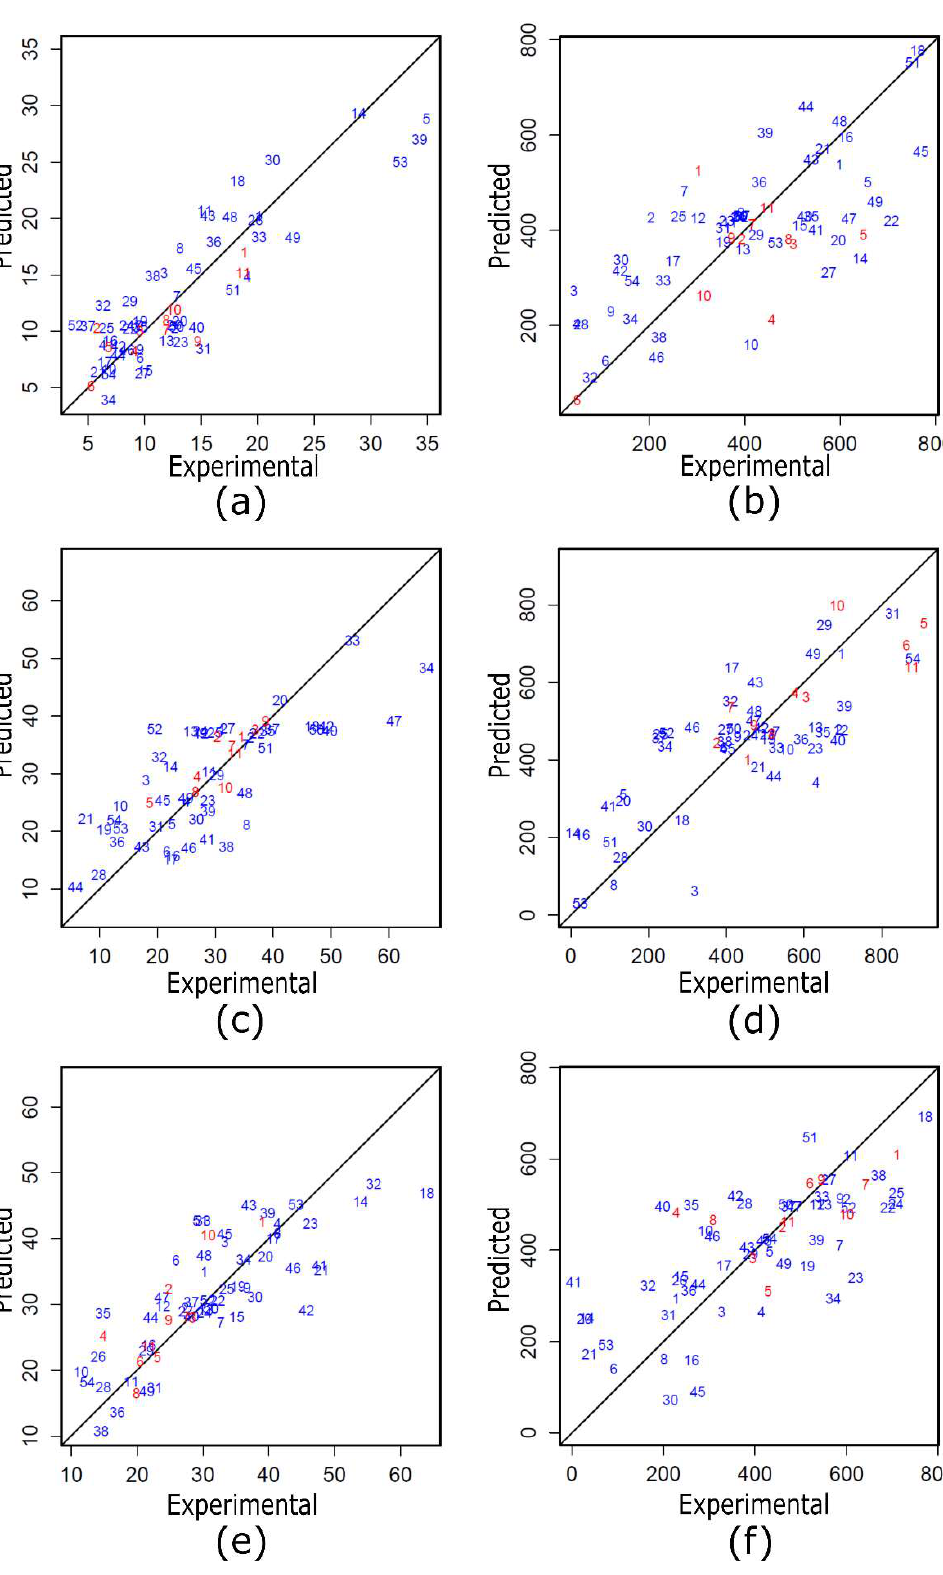
Figure 1. Scatter diagrams of ECOTAN BIO 90D: ( a ) finTurb and ( b) TSS; ECOTAN BIO 100: ( c ) finTurb and ( d ) TSS; and ECOTAN BIO G150: ( e ) finTurb and ( f) TSS.